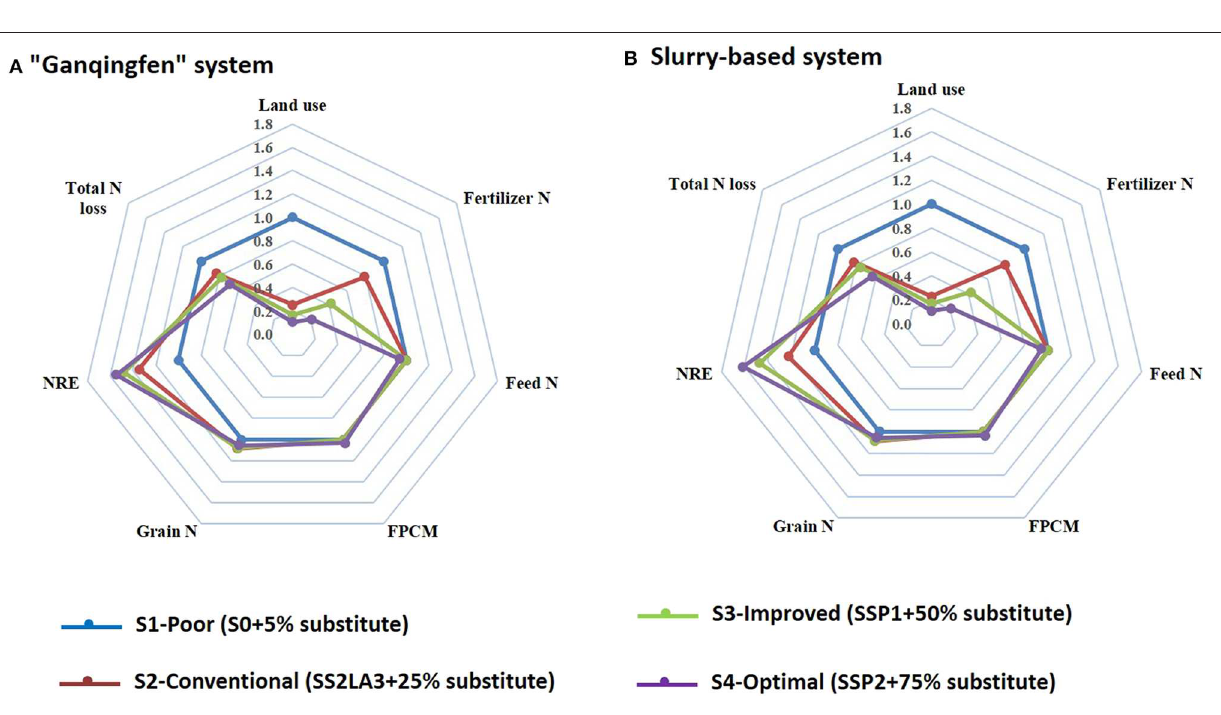
FIGURE 6 | Impacts on resource use, N losses, and use in the manure management chain under different management scenarios. (A) “Ganqingfen” system. (B) Slurry-based system. (Notes: FPCM is fat and protein corrected milk, which fat and protein content is 4 and 3.3% respectively; here we use it as function